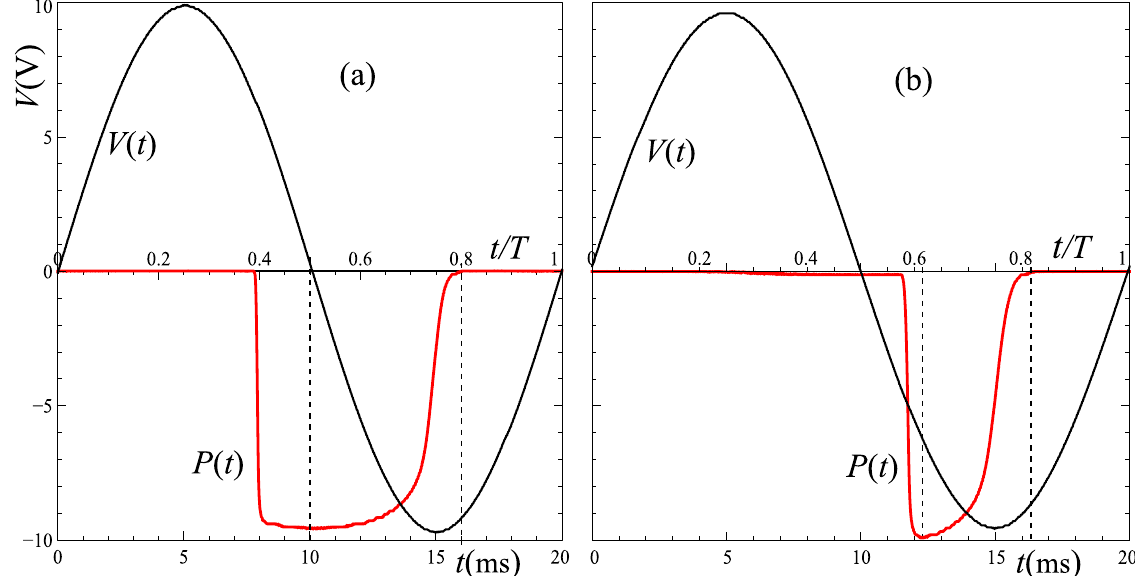
Figure 3. A sinusoidal driving voltage, V ( t ) = V 0 sin (ω t ) , and the optical power output, P ( t ), (inverted for clarity) from one of the two anti-parallel LED chains, L 2 , for: ( a ) 1 LED in each chain, and V 0 = 10 V (case (i)); ( b ) 4 LEDs in each, and V 0 = 9.5 V (case (ii)). Vertical dotted lines mark switch off of the optical power, and the points of maximum optical power. The voltage scale refers to V ( t ), the optical power being an arbitrary scale for each photo-diode